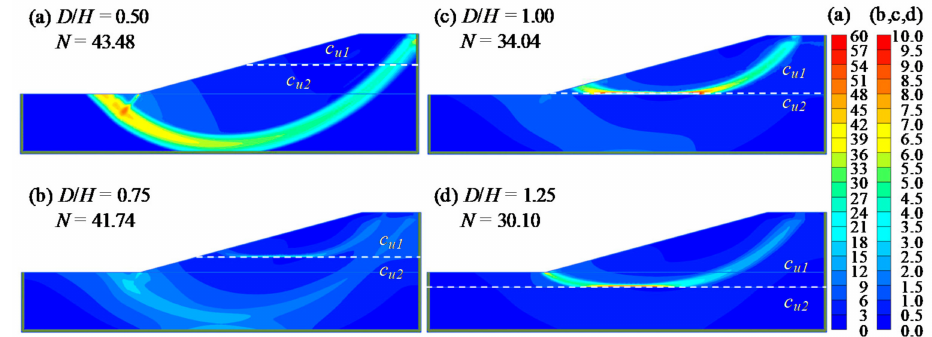
Figure 9. Total deviatoric strain according to D / H , where T / H = 2, H / B = 0.5, c u 1 / c u 2 = 0.5, β = 15 ◦ ( a ) D / H = 0.50, ( b ) D / H = 0.75, ( c ) D / H = 1.0, and ( d ) D / H =